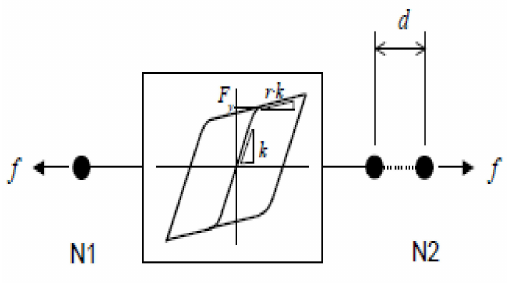
Figure 11. Hysteric system of resilient friction